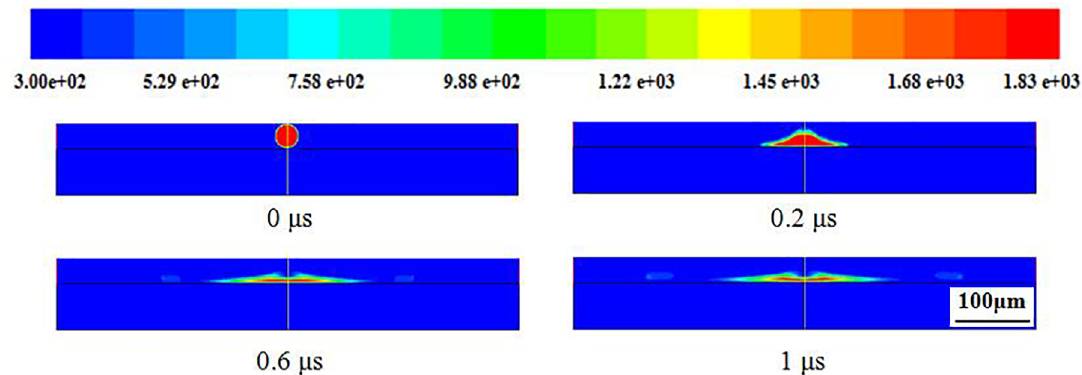
Figure 10. Changes of a droplet temperature field with time for Ø 50 µm and 200 m/s